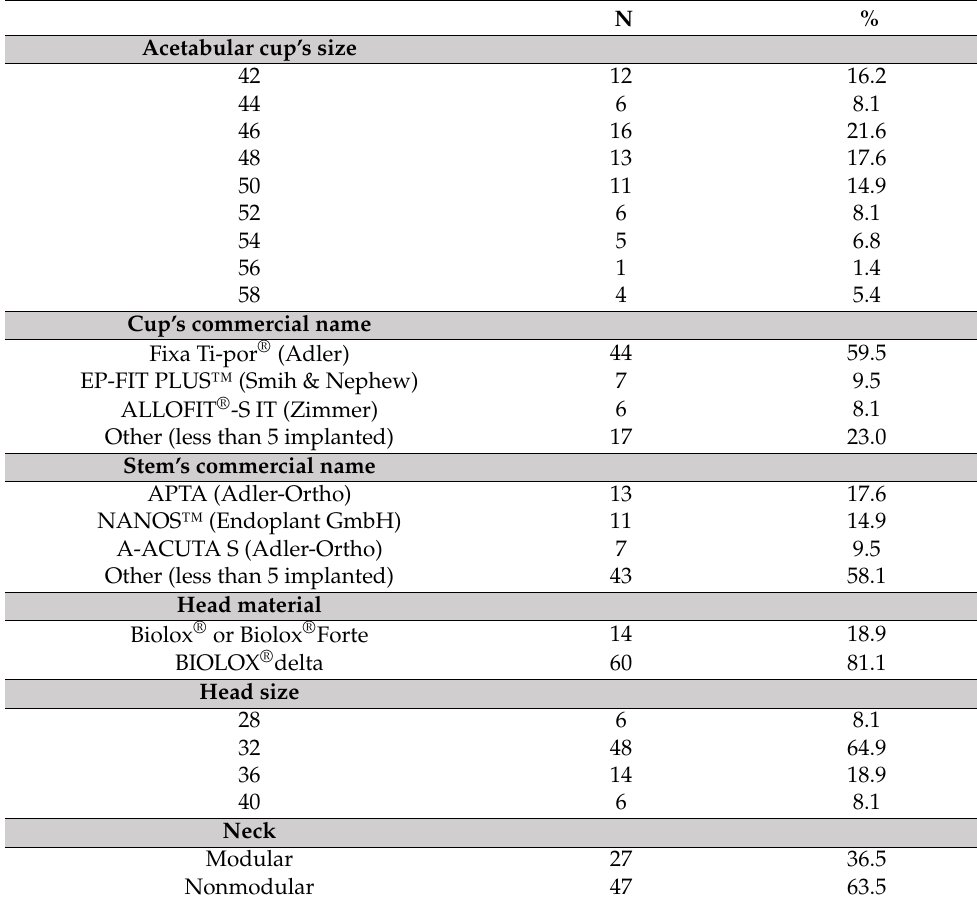
Table 3. Implants